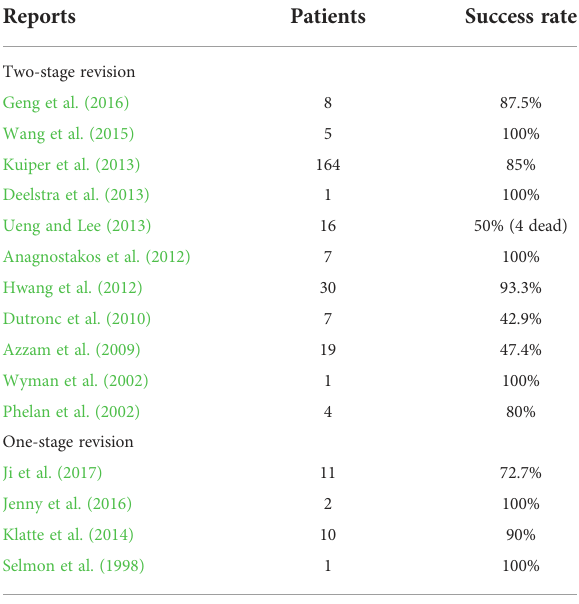
TABLE 2 Success rates of two-stage revision and one-stage revision for fungal